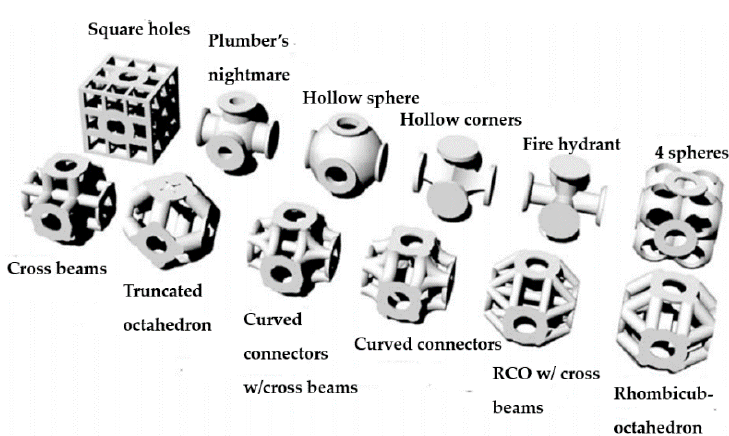
Figure A3. Unit cells [144].